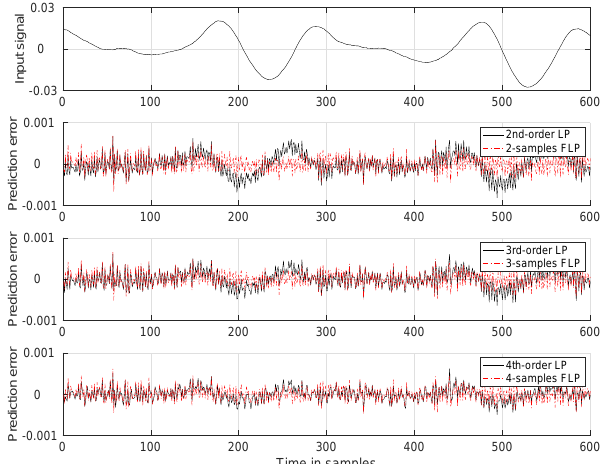
Figure 4. The prediction error results for the musical signal (Strauss–BlueDanube–ex1, from the Orchset) for second-order, third-order and fourth-order LP and the FLP with the two-sample, three-sample, and four-sample